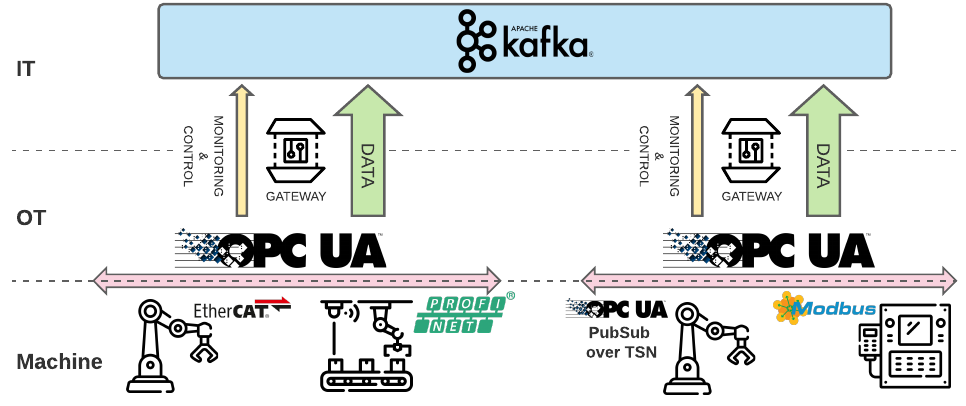
Figure 2. Architecture overview